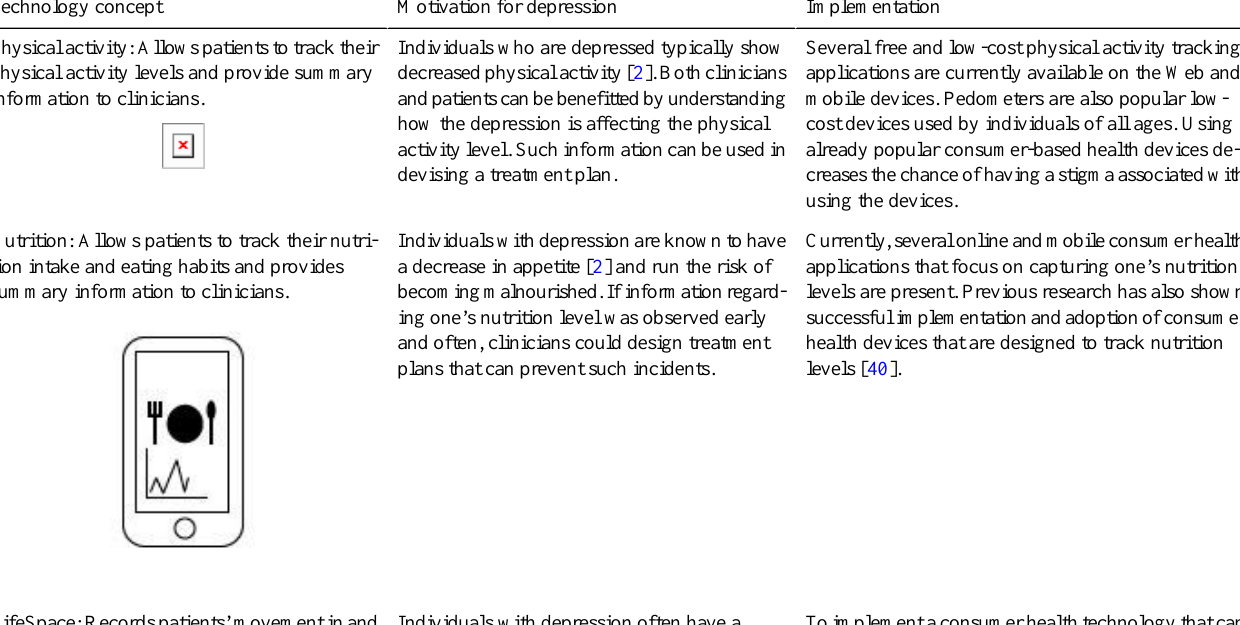
ImplementationMotivation for depressionTechnology